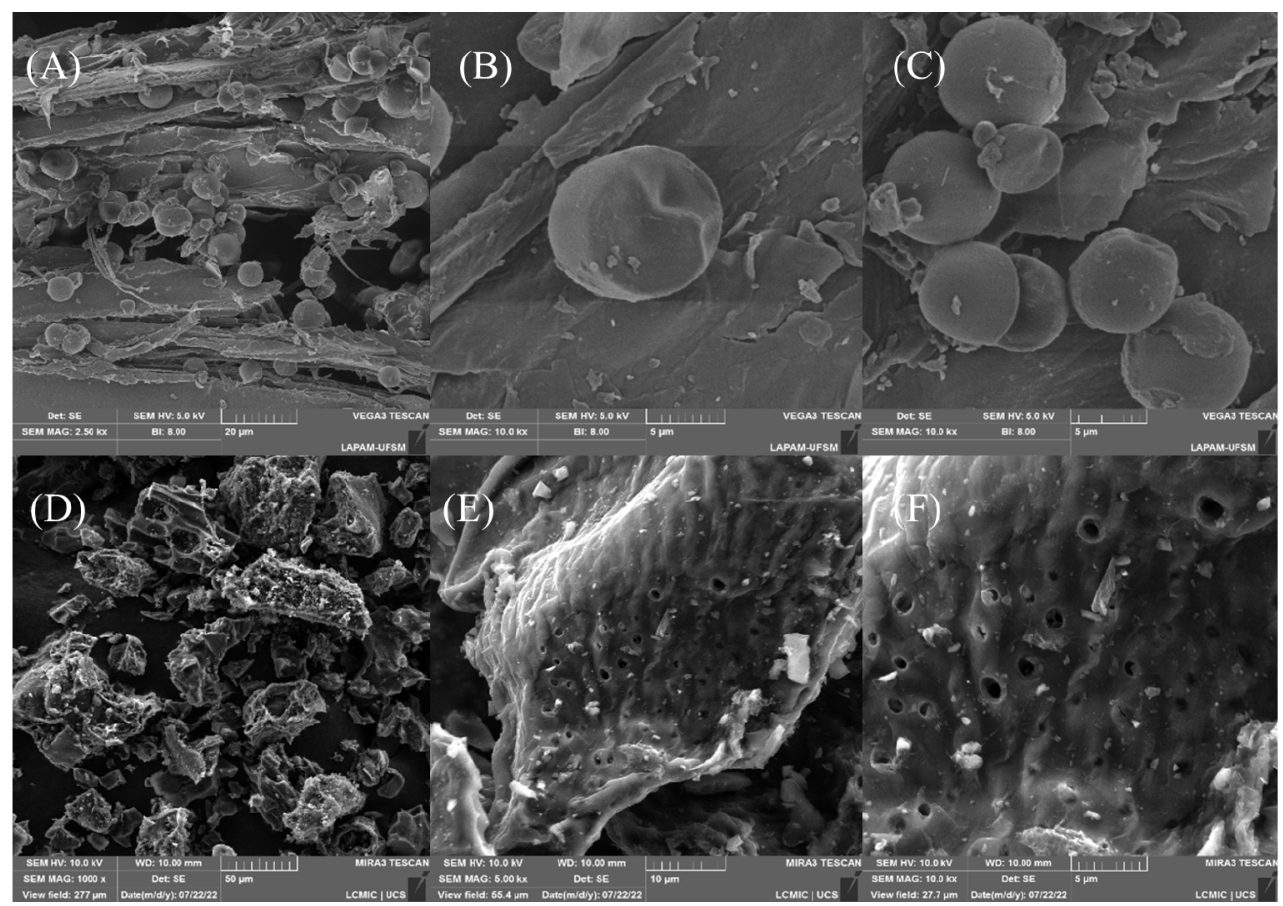
Figure 2. Micrographs of the material surface before ( A – C ) and after carbonization ( D – F ).